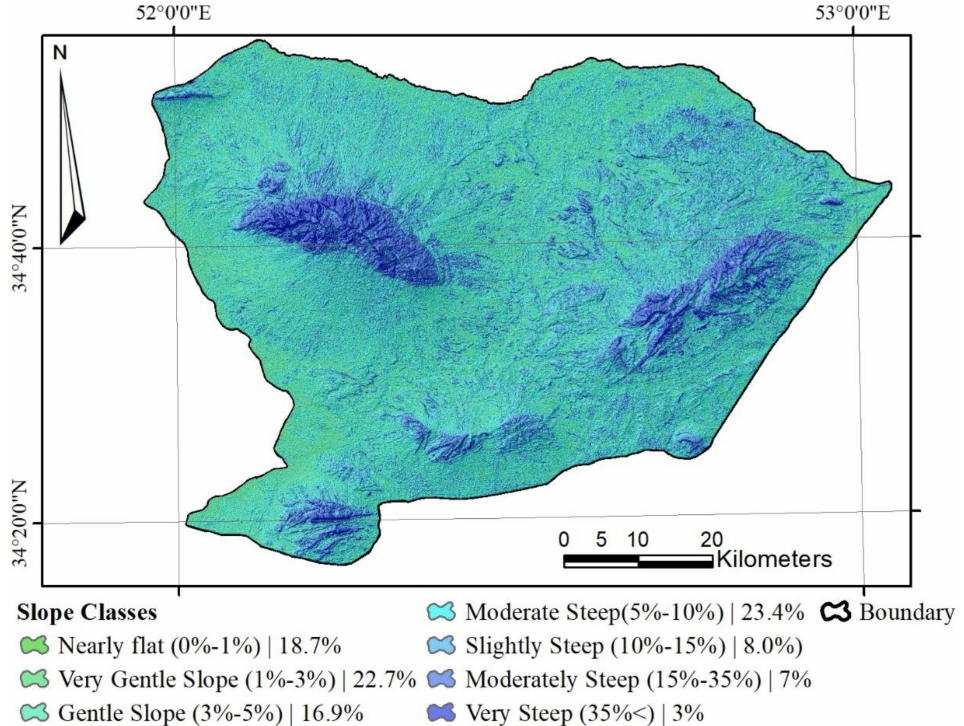
Figure 5. Slope map of the Kavir National Park. Values proceeding the categories indicate the share of di ff erent classes from the total